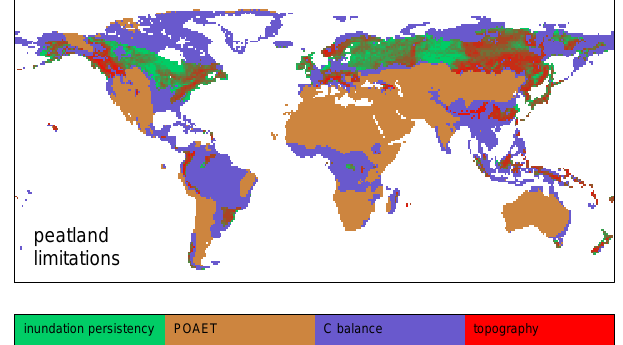
Figure 10. Global distribution of limitations to peatland establish- ment. The mapping follows from the assessment of pt crit as de- scribed in Sect. 4.1. The primary limitation is given by precipitation divided by evapotranspiration (POAET < 1). Long-term C accumu- lation sets a secondary limitation (purple). Within the green areas, peatland area fraction may extend to its potential maximum f pot peat (not shown), which is limited by inundation persistency. The latter is subject to the soil water balance and topography. Limitation by topography is represented by the theoretical maximum inundation fraction f max (see Eq. 4), shown as red for f max = 0 and green for f max = 1, and interpolated colours for values in